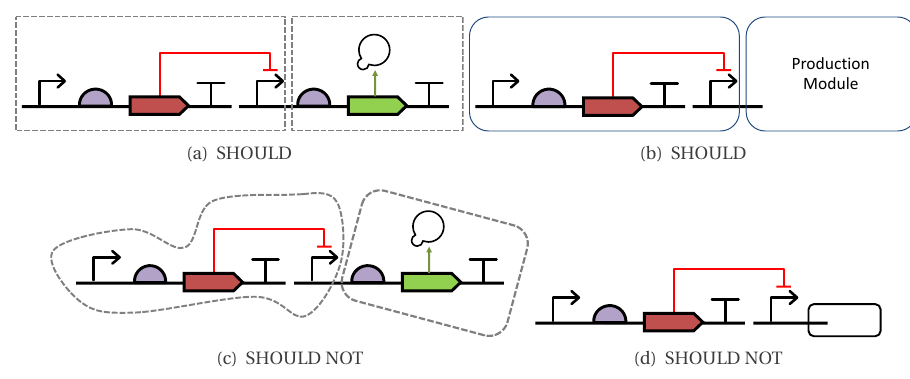
Figure 19: Examples of recommended and problematic module boundaries: (a) two modules with visually distinct rectangular borders, (b) shows the same modules but with rounded rectangles and the second being a “black box” module with no internal structure shown, (c) shows modules with non-rectilinear borders, and (d) shows a black-box module that is not visually distinct from a sequence feature glyph.